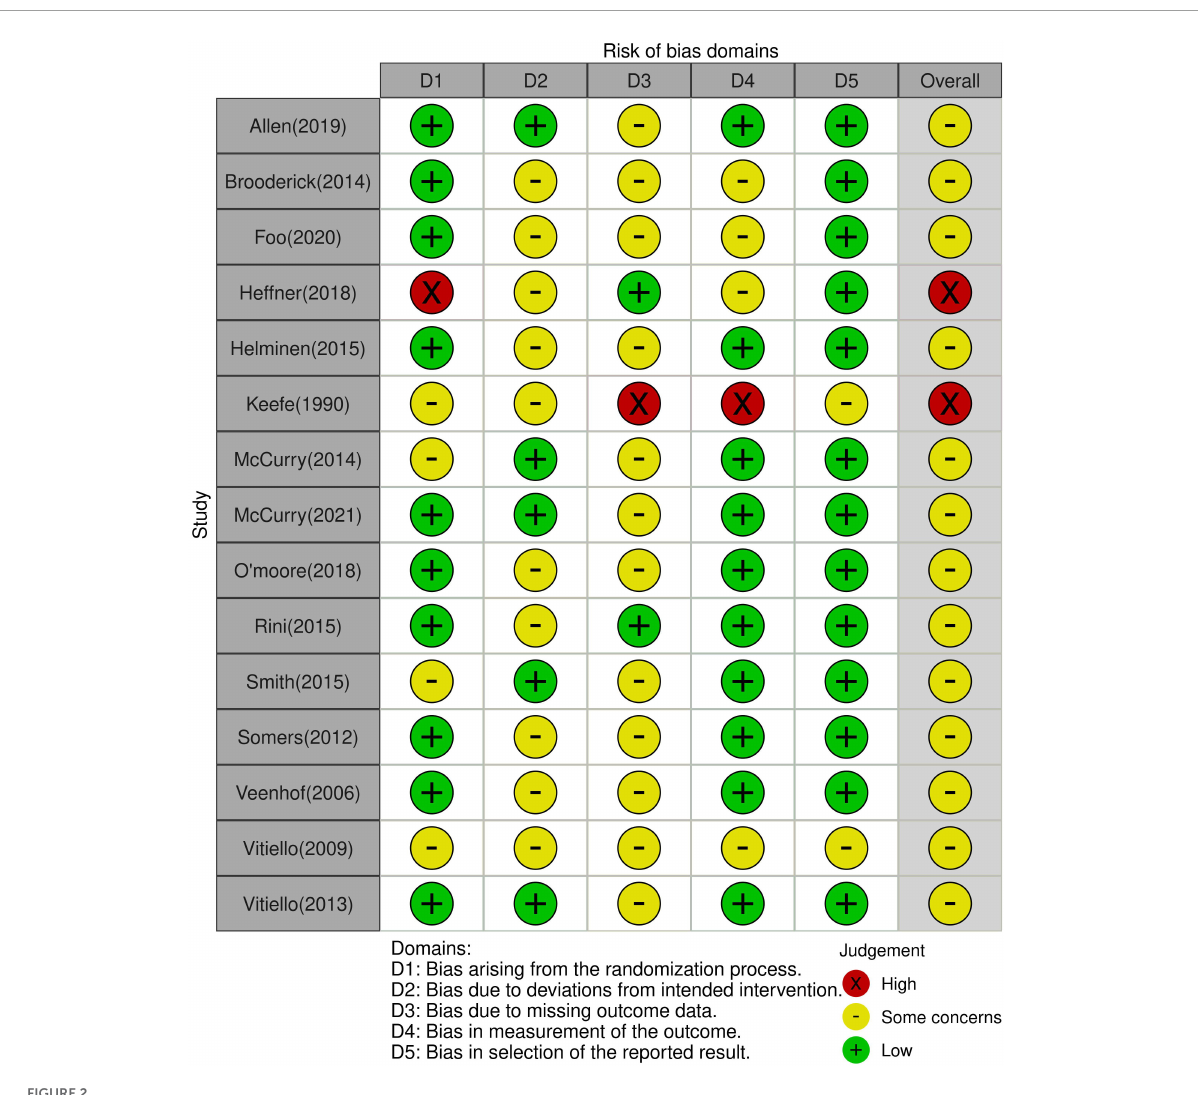
FIGURE2 Risk of bias summary of individual studies based on reviewers’